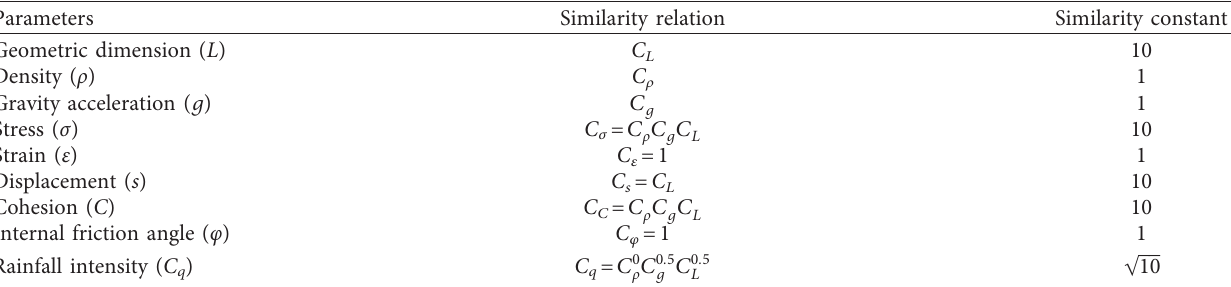
Table 2: Similarity ratios of the test